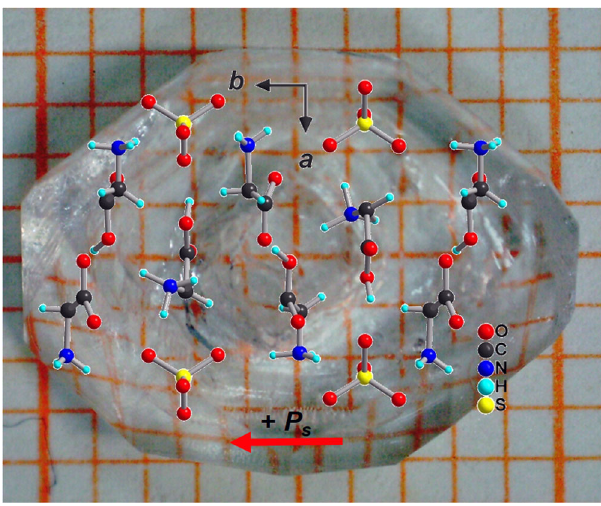
Fig. 6 TGS crystal. View of an as grown TGS crystal with the molecular